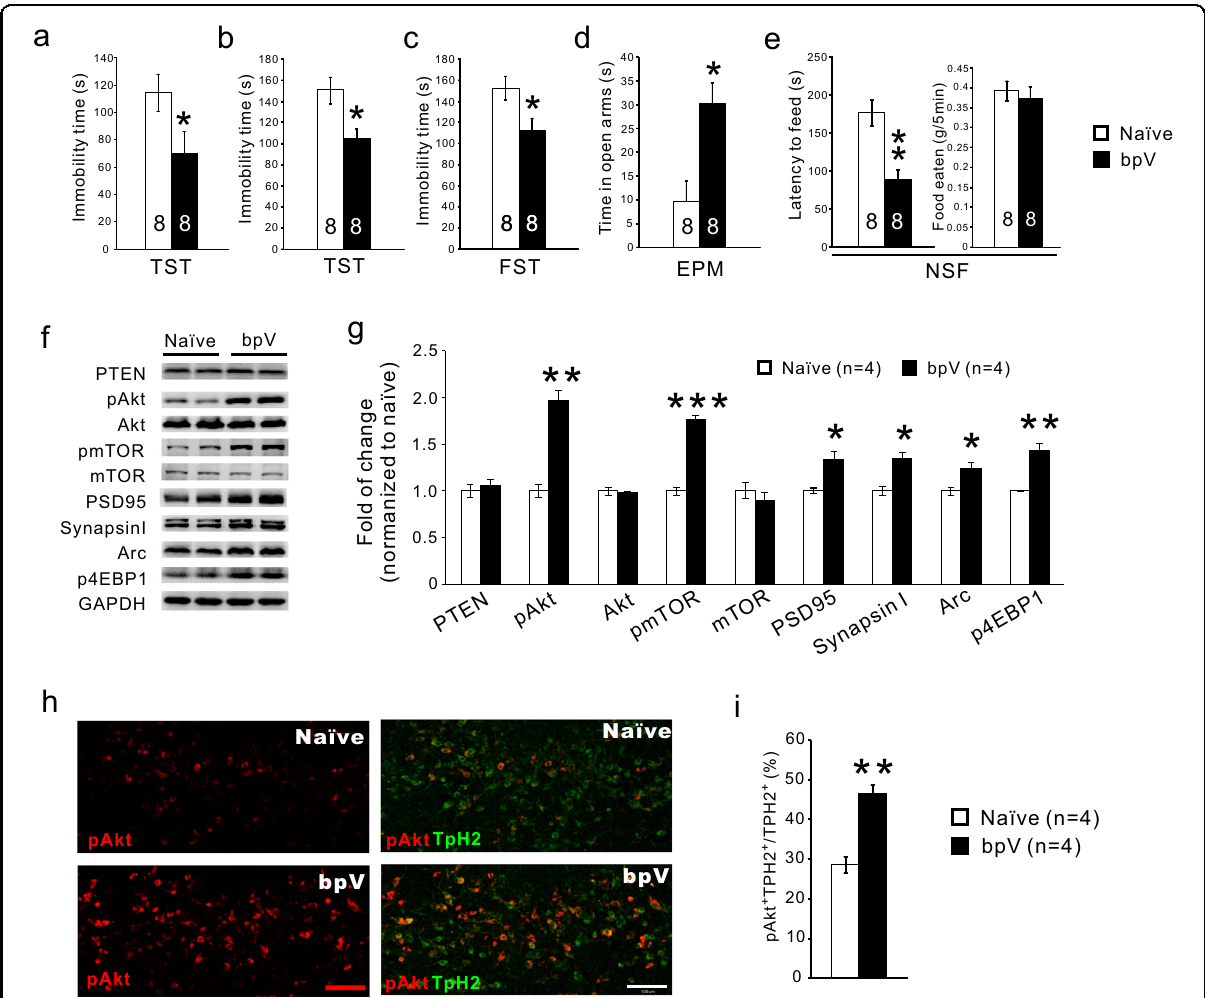
Fig. 5 Inhibition of PTEN with bpV has signi fi cant antidepressant effects. a Immobility time in tail suspension test (TST) is reduced 3 days after daily administration of bpV. b, c Immobility time in TST and force swimming test is reduced 3 weeks after daily administration of bpV. d , e . Time spent in the open arm is increased in the elevated plus-maze test ( d ) and latency to eating food is reduced in the novelty suppressed feeding test ( e ) 3 weeks after daily administration of bpV. f, g Three-week systemic administration of bpV upregulates pAkt, pmTOR1, PSD-95, synapsinI, Arc, and p4EBP1 levels with no changes in PTEN, Akt, or mTOR1 in midbrain tissue containing the dorsal raphe nucleus. h , i Double immunostaining of TPH2 and pAkt shows the elevation of pAkt in 5-HT neurons in the DRN of bpV-treated mice. All the data are presented as the mean ± s.e.m. * p < 0.05, ** p < 0.01, *** p < 0.001. Numbers of animal used are